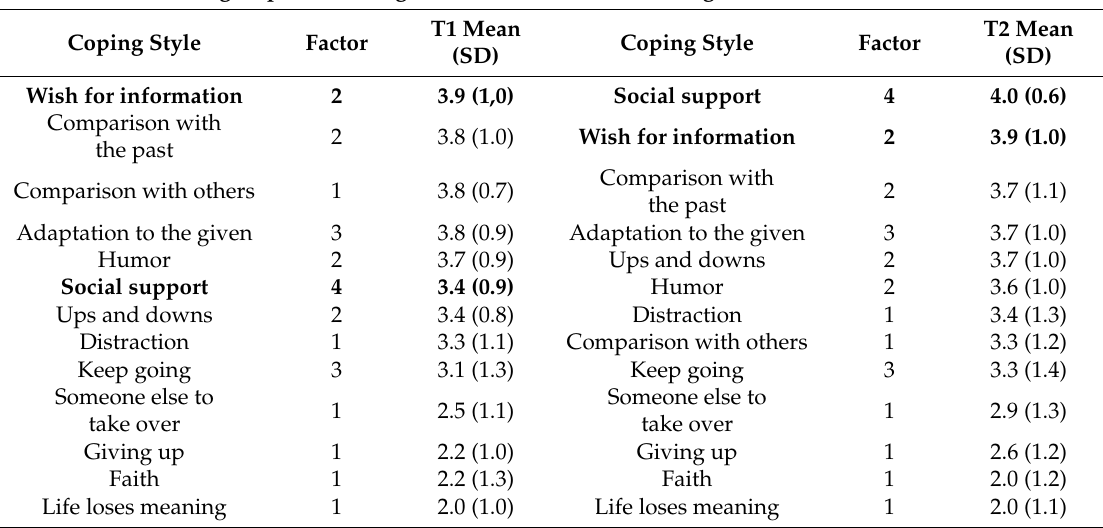
Table 6. Rating of coping styles over time, by Hoehn and Yahr (HY) subgroups; Factor solution revealed at baseline, in short: 1 = pessimistic, 2 = optimistic, 3 = persistent, 4 = support-seeking. HY Subgroup “Worsening”, i.e., Low (HY 1–2) at T1, High (HY 3–5) at T2 ( n = 29)